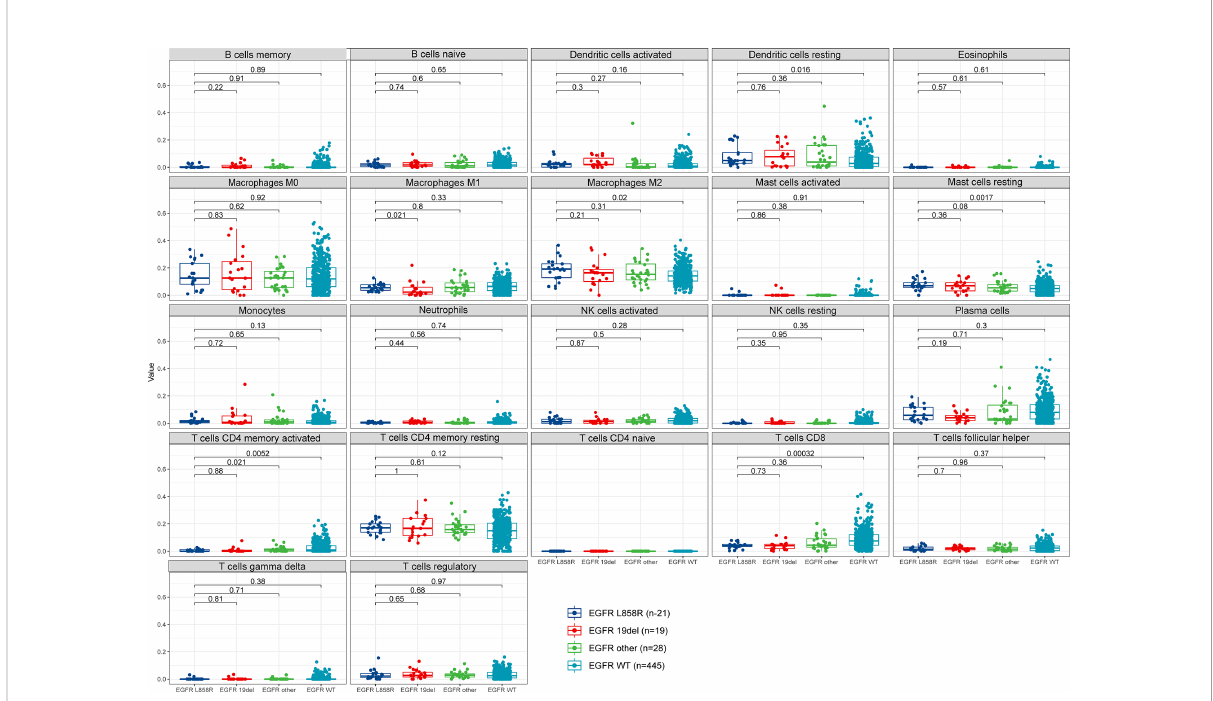
FIGURE 8 TME in NSCLC from TCGA database. TME, tumor microenvironment. TCGA, The Cancer Genome